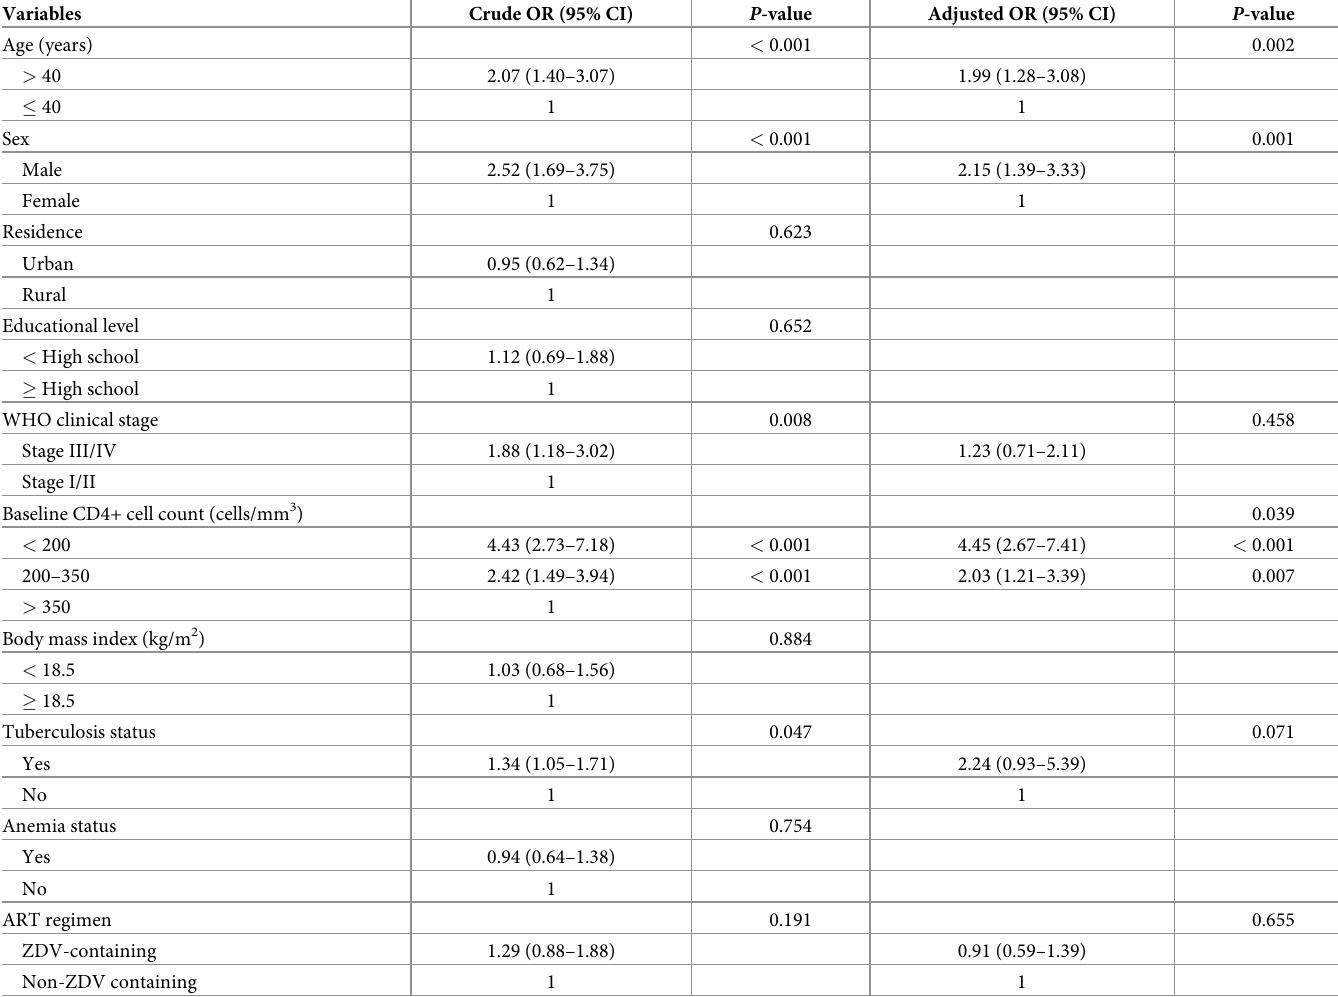
Table 3. Factors associated with poor CD4+ cell count recovery to > 500 cells/mm 3 among 434 patients initiating ART with CD4+ cell counts � 500 cells/mm 3 at 12 months.